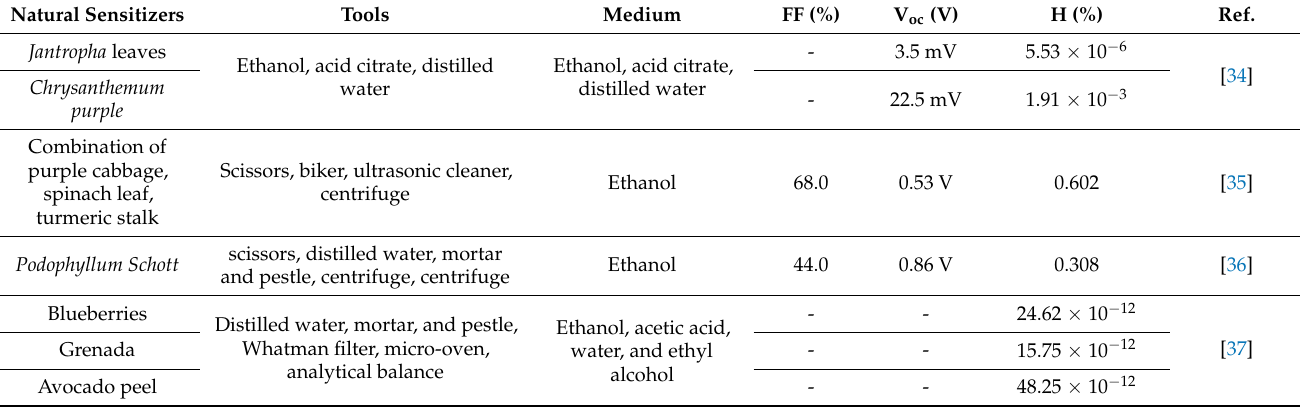
Table 2. Extraction methods of natural dyes for DSSC